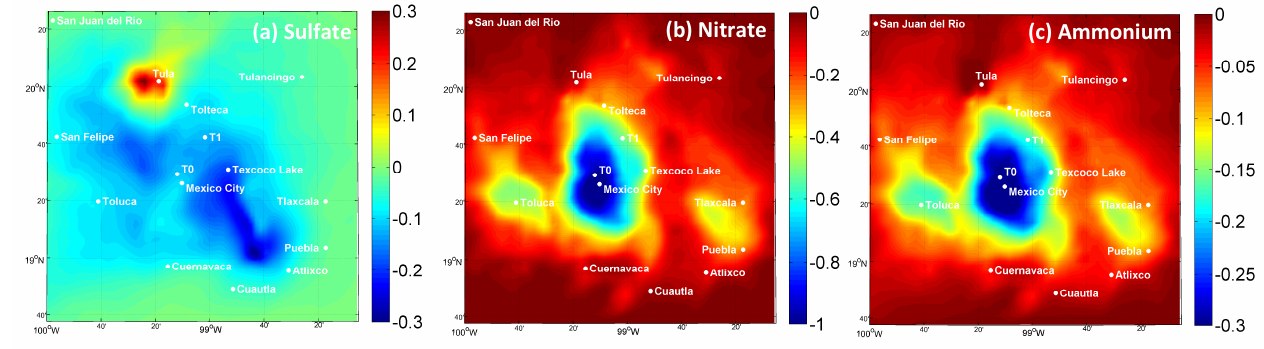
Fig. 13. Predicted change (µgm − 3 ) in ground-level concentrations of PM 1 (a) sulfate, (b) nitrate, and (c) ammonium after a 50% reduction of NO x emissions. A negative change corresponds to a decrease.